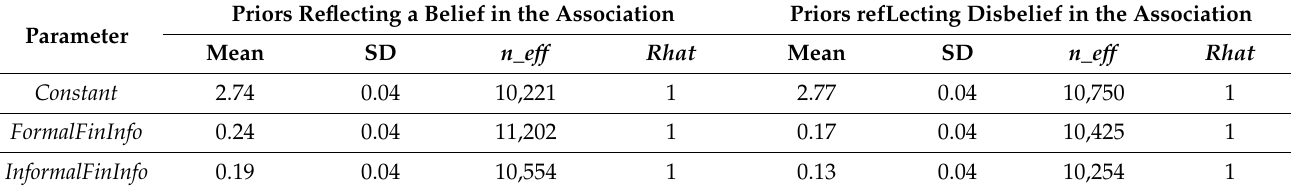
Figure 5. Model 2’s trace plots. Figure 5. Model 2 ′ s trace plots. Table 3. Model 2’s simulated Table 3. Model 2 ′ s simulated posteriors.